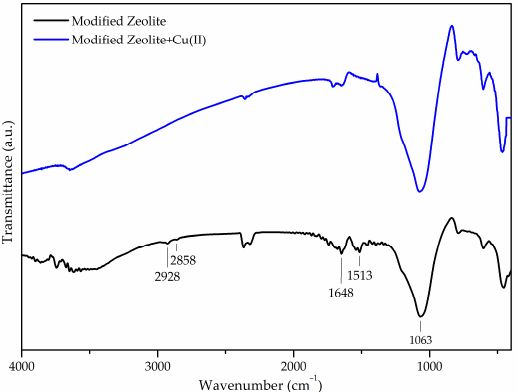
Figure 9. FT-IR spectra of modified zeolite, before and after the adsorption of Cu(II).